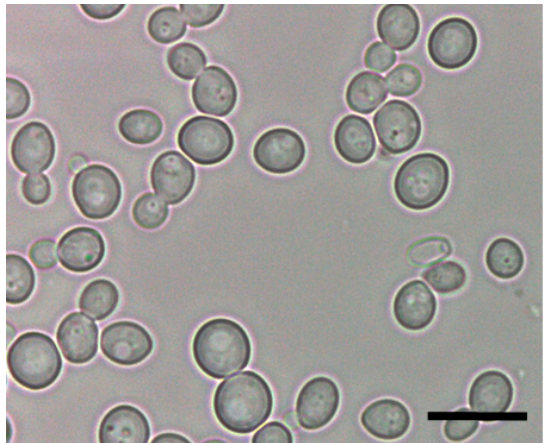
Figure 1. Cell morphology and shape of Metschnikowia pulcherrima . Graphical scale 10 μ m.